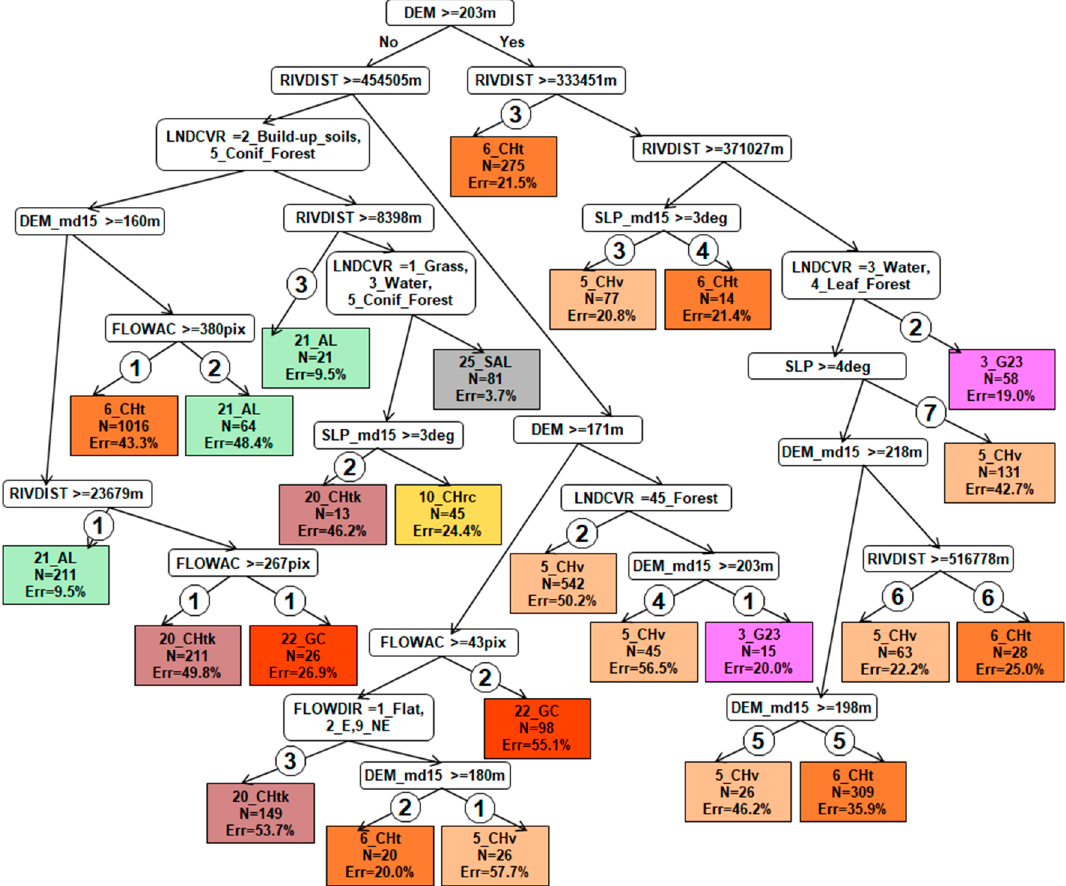
Figure 6. EVTREE quantitative decision tree № 5 for the Chernozems soil zone in the Belgorod region (Soil Types: 3_G23—Greyic Phaeozems Albic, 5_CHv—Voronic Chernozems Pachic, 6_CHt—Voronic Chernozems Pachic, 10_CHrc—Leptic Chernozems, 20_CHtk—Leptic Voronic Chernozems